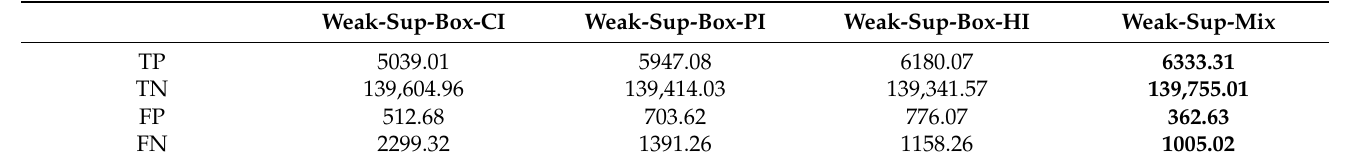
Figure 4. Evolution of the segmentations starting from their initialization state over the course of training. Masks gradually approach the ground truth label as training progresses. The first column shows images with the bounding box annotations that are used to guide the learning process. The second column shows the initial set of masks generated with different approaches: images ( b , f ) use model prediction as initial masks, while images ( j , n ) use circles as initial masks. Table 3. Confusion matrices from weakly supervised models’ predictions on one split of the validation